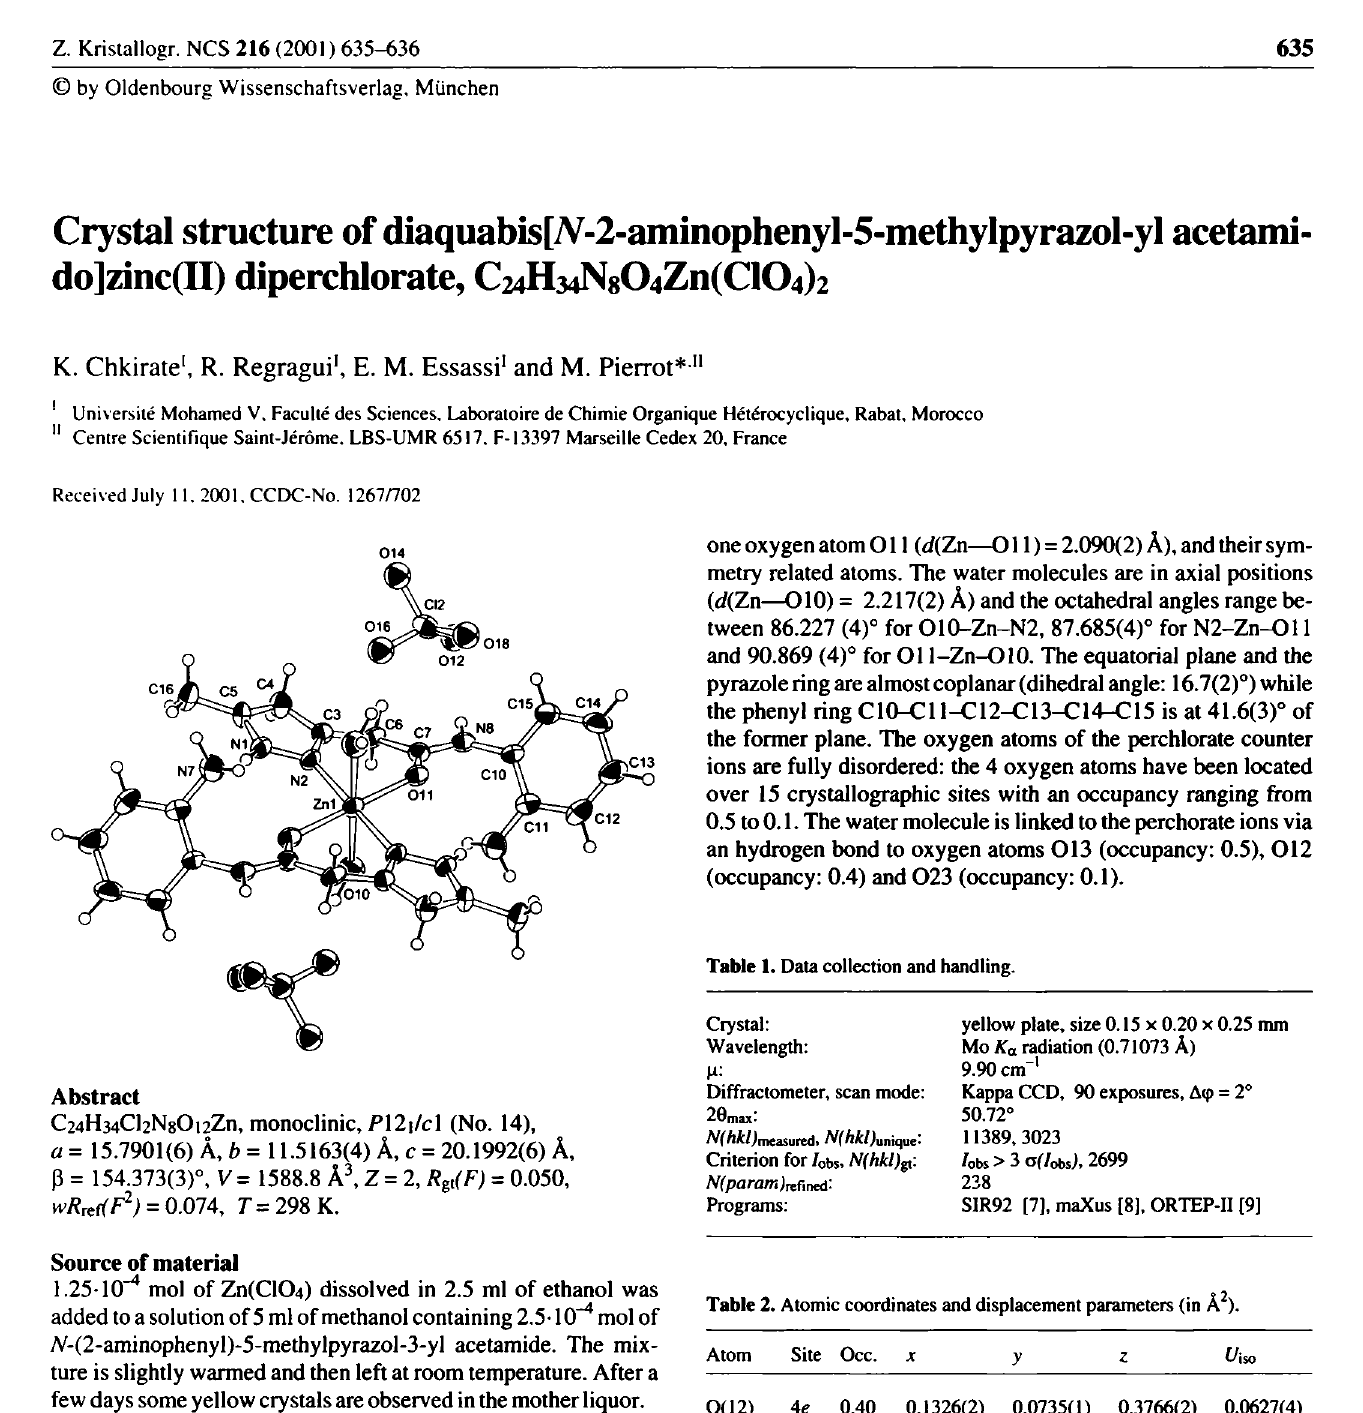
Table 2. Atomic coordinates and displacement parameters (in Ä 2